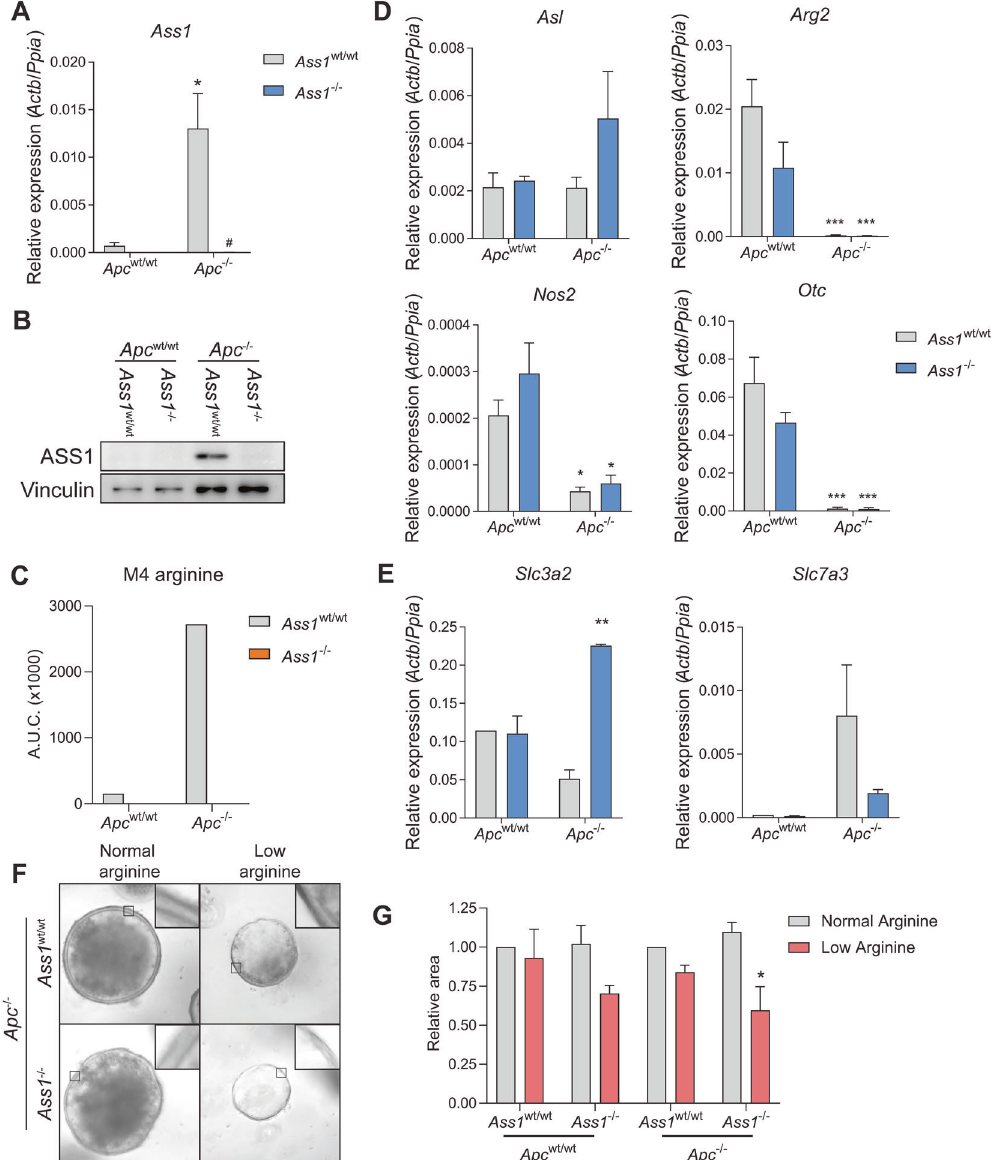
Fig. 6 Growth of Ass1 -de fi cient small intestinal organoids is impaired in arginine-low conditions only and arginine transporters could compensate for loss of Ass1 . A qRT-PCR for Ass1 in Ass1 and Apc knockout organoids. Actb and Ppia are used as reference genes. * p < 0.05 compared to Ass1 wt/wt Apc wt/wt organoids, # p < 0.05 compared to Ass1 wt/wt Apc − / − organoids by one-way ANOVA with Tukey ’ s multiple comparisons test. B Western blot for ASS1 and Vinculin in Ass1 and Apc knockout organoids. C Intracellular LC-MS measurements of M4 arginine in organoids cultured with M4 citrulline (U-13C;3,3,4-D3). D qRT-PCR for indicated urea-cycle genes. E qRT-PCR for indicated amino acid transporters. * p < 0.05, *** p < 0.001, **** p < 0.0001 by one-way ANOVA with Tukey ’ s multiple comparisons test. F Microscopic bright- fi eld images of organoids cultured in regular and low-arginine medium. Representative images are shown. Scale bar represents 100 µm. G Quanti fi cation of organoid size cultured in regular and low-arginine medium ( n = 3 independent experiments) * p < 0.05 student ’ s t in fl uenced by activation of the Wnt signaling pathway, such as had no effect on tumorigenesis in a mouse model that is HIF1alpha and ATF4, are likely to also in fl uence Ass1 expression representative with the mutational spectrum of 80% of sporadic [43, 44]. human colorectal cancers. Also, we found no role for epithelial The loss of Ass1 in the context of an Apc mutation does seem to Ass1 during regeneration in a model of irradiation-induced lead to intrinsic compensation by amino acid transporters and epithelial damage and repair. Ass1 expression is increased extrinsic compensation by distant organs like the liver. As we speci fi cally by deletion of Apc and the urea-cycle fl ux is arrested. show, arginine transporters are upregulated in Ass1- de fi cient The correlation we fi nd between Apc and Ass1 is most likely organoids allowing more arginine uptake from the medium. At mediated through translocation of beta catenin to the nucleus the same time, serum glutamine levels are increased and with subsequent activation of the Wnt target gene cMyc , which hepatocytes alter their arginine metabolism, by which the amino has been shown to bind to the promoter of Ass1 and increase Ass1 acid demand in the intestinal tissue can be met. This is similar to expression [42]. Other transcription factors that can indirectly be